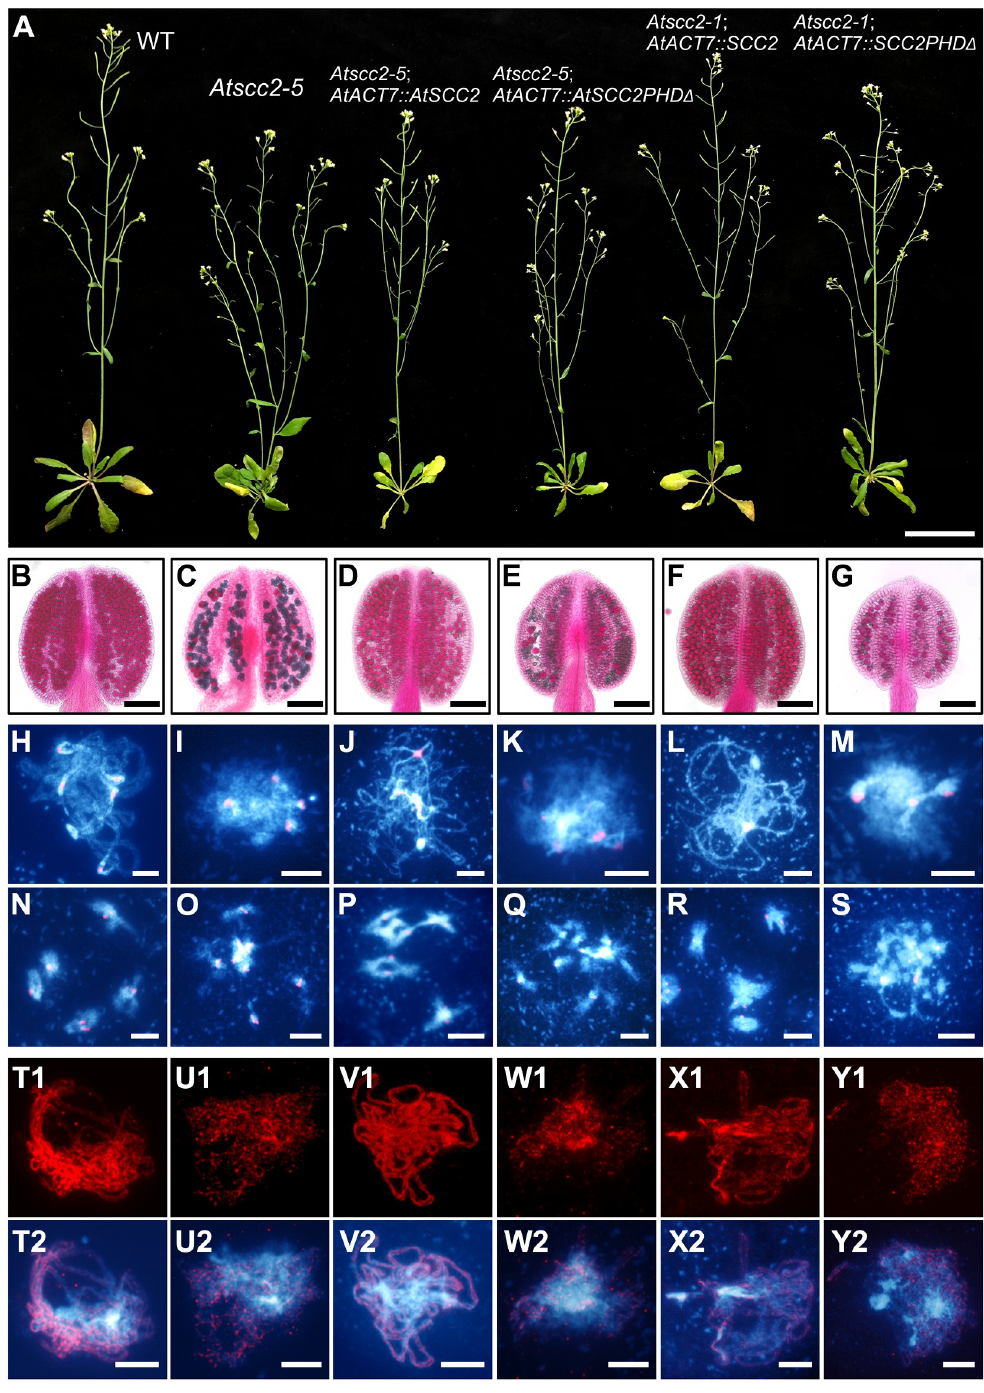
Fig 8. The AtSCC2 PHD domain is indispensable for male meiosis but not mitosis. (A) WT, Atscc2-5 , Atscc2-5 ; AtACT7 :: AtSCC2 , Atscc2-5 ; AtACT7 :: AtSCC2PHD Δ , Atscc2-1 ; AtACT7 :: AtSCC2 and Atscc2-1 ; AtACT7 :: AtSCC2PHD Δ plants. Bar = 3 cm. (B-G) Alexander staining of the corresponding anthers. Bar = 100 μ m. (H-S) DAPI stained chromosome spreads and FISH with centromere probes at pachytene and diakinesis from the plants shown in panel A. Bar = 5 μ m. (T1-Y2) Distribution of AtSYN1 signal at pachytene in meiocytes from the corresponding plants. Bar = 5 μ m.